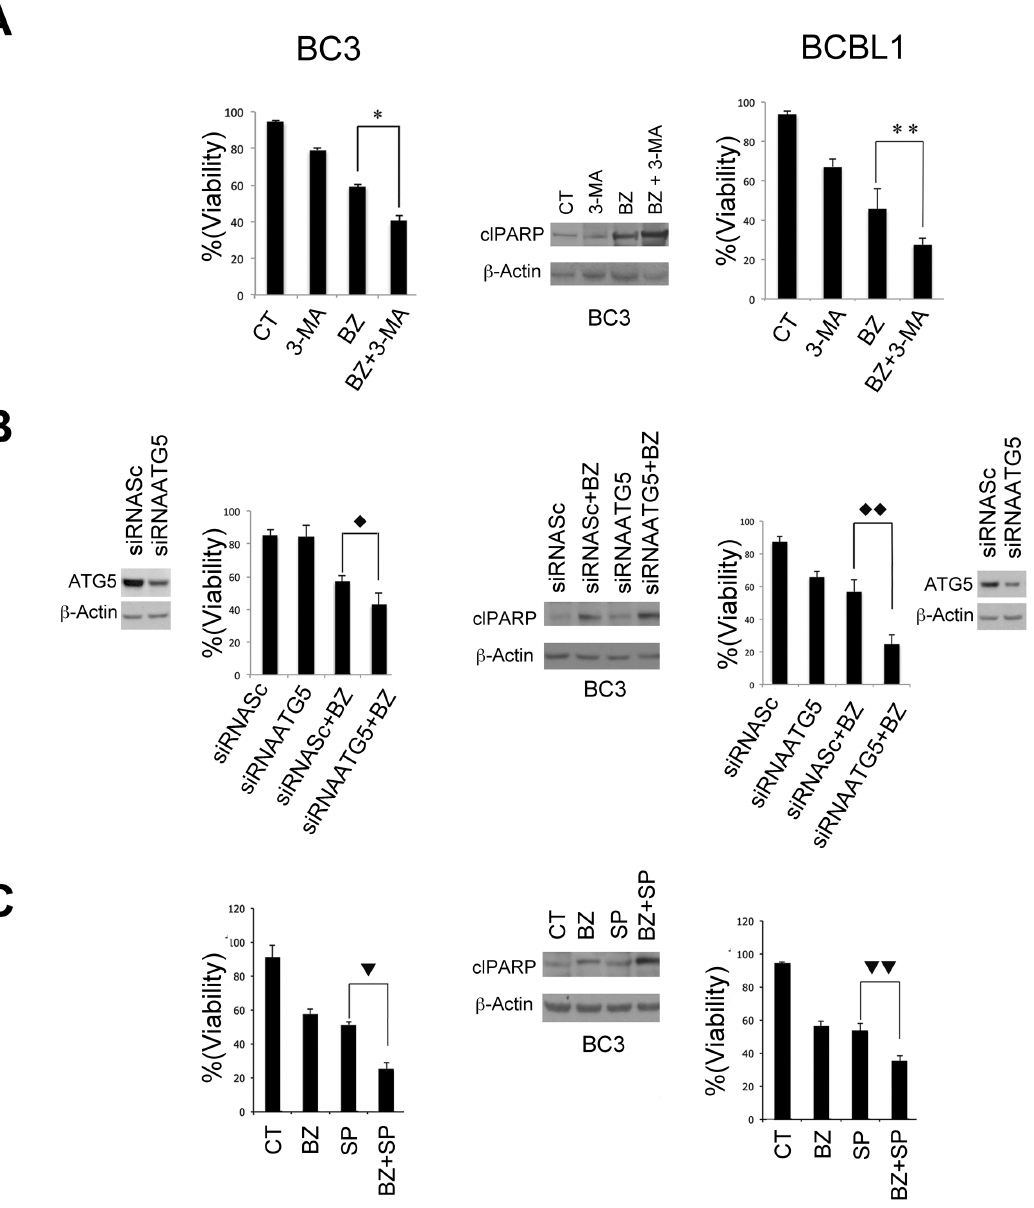
Figure 4. Inhibition of autophagy and JNK increases the Bortezomib anti-proliferative effect in BC3 and BCBL1 PEL cells. (A) Viability assay evaluated by trypan blue exclusion was performed in BC3 (left panel) and BCBL1 (right panel) cells treated with bortezomib (20 nM) or 3-MA (5 mM) alone or in combination for 16 hrs. Mean 6 the standard deviation was also indicated (n=3 experiments). * p-value = 0.05, ** p-value = 0.02. Western blotting analysis was performed on BC3 cells to evaluate the expression of cleaved (cl) PARP p85 fragment (middle panel). b -actin was used as loading control. (B) BC3 and BCBL1 cells were transfected with ATG5 siRNA or scramble siRNA (siRNASc), and than a western blot was performed with the anti-ATG5 antibody. b -actin was used as loading control. Viability assay evaluated by trypan blue exclusion was performed in BC3 and BCBL1 cells ATG5 or scramble-knocked down upon bortezomib treatment (20 nM) for 16 hrs. Mean 6 the standard deviation was indicated (n=3 experiments). ¤ p-value = 0.02, ¤¤ p-value = 0.03. Western blotting analysis was also performed on BC3 cells to evaluate the expression of PARP p85 fragment (cl PARP) and b -actin was used as internal control. (C) Cells viability assay on BC3 and BCBL1 cells treated with bortezomib (20 nM) and SP600125 (20 m M) alone or in combination for 16 hrs. The percentage of live cells was evaluated by trypan blue exclusion assay. Mean 6 the standard deviation was indicated (n=3 experiments). p-value = 0.01, p-value = 0.01. Western blotting analysis was performed on BC3 cells to evaluate the expression of PARP p85 fragment (cl PARP) and b -actin was used as loading